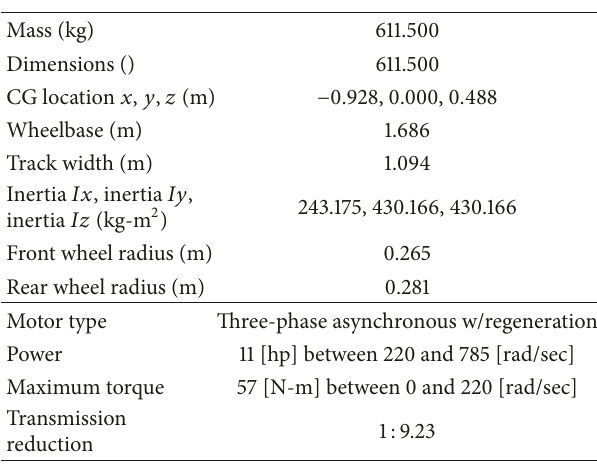
Table 1: Real platform parameters.